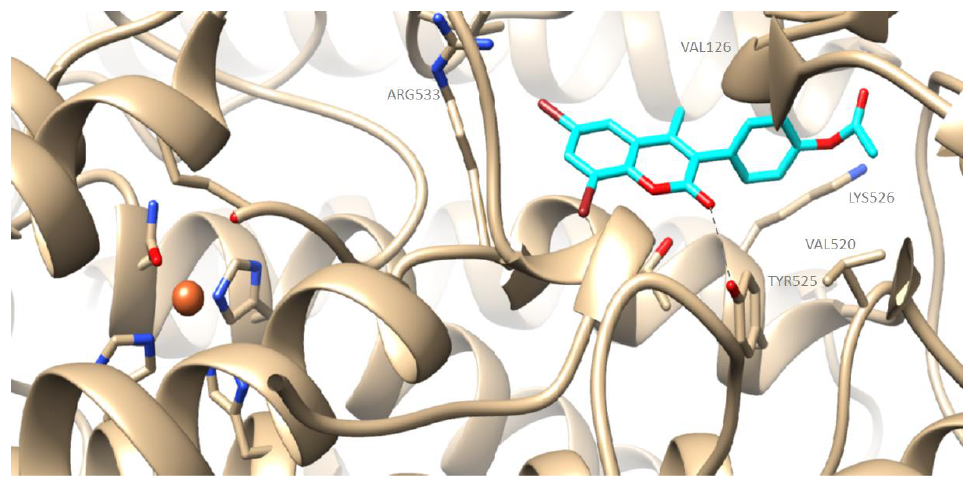
Figure 2. Preferred docking pose of 3k (depicted in cyan) bound to soybean lipoxygenase (LOX-1).